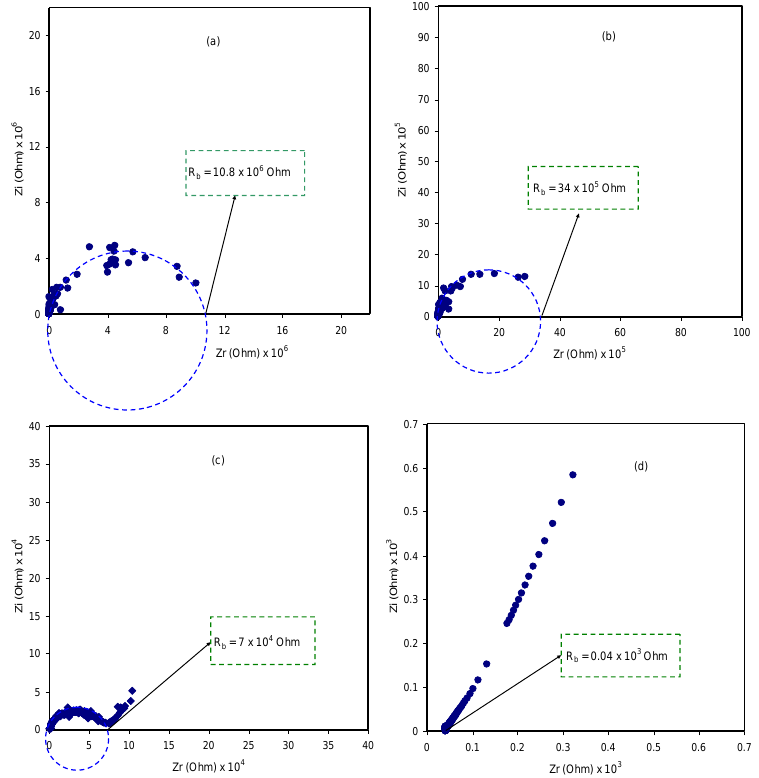
Figure 5. Impedance plots of ( a ) CSDPE1, ( b ) CSDPE2, ( c ) CSDPE3, and ( d ) CSDPE4 blended films at ambient temperature.